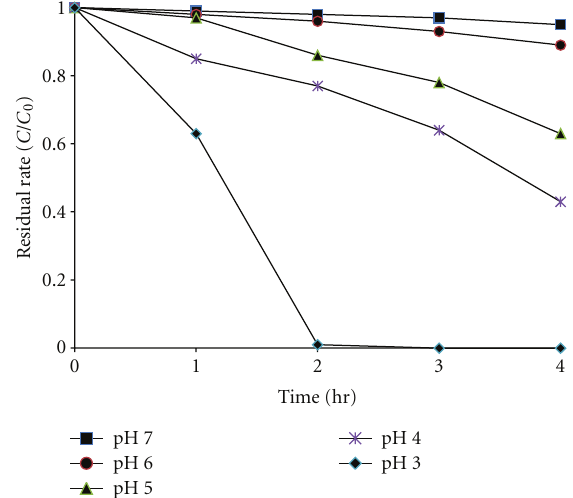
Figure 6: Residual rates of sodium oxalate under the photoelectro- catalytic reaction at di ff erent pH.